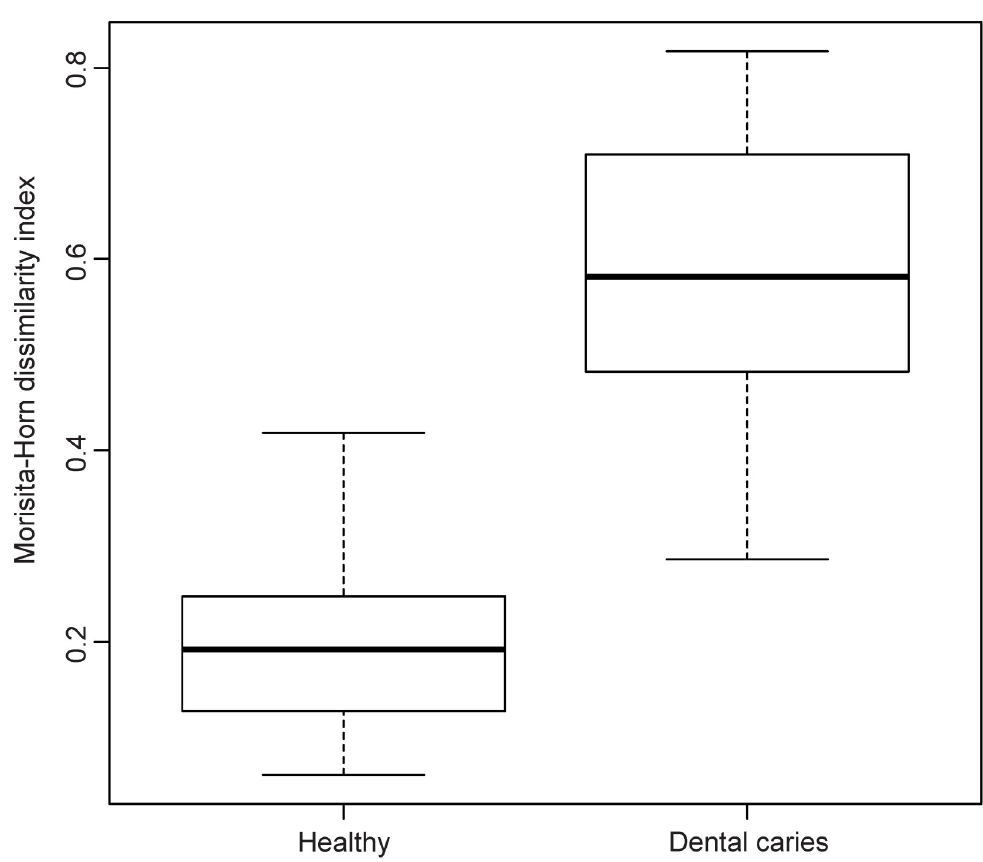
Fig 4. Similarity of microbiome composition. Boxplots of Morisita-Horn